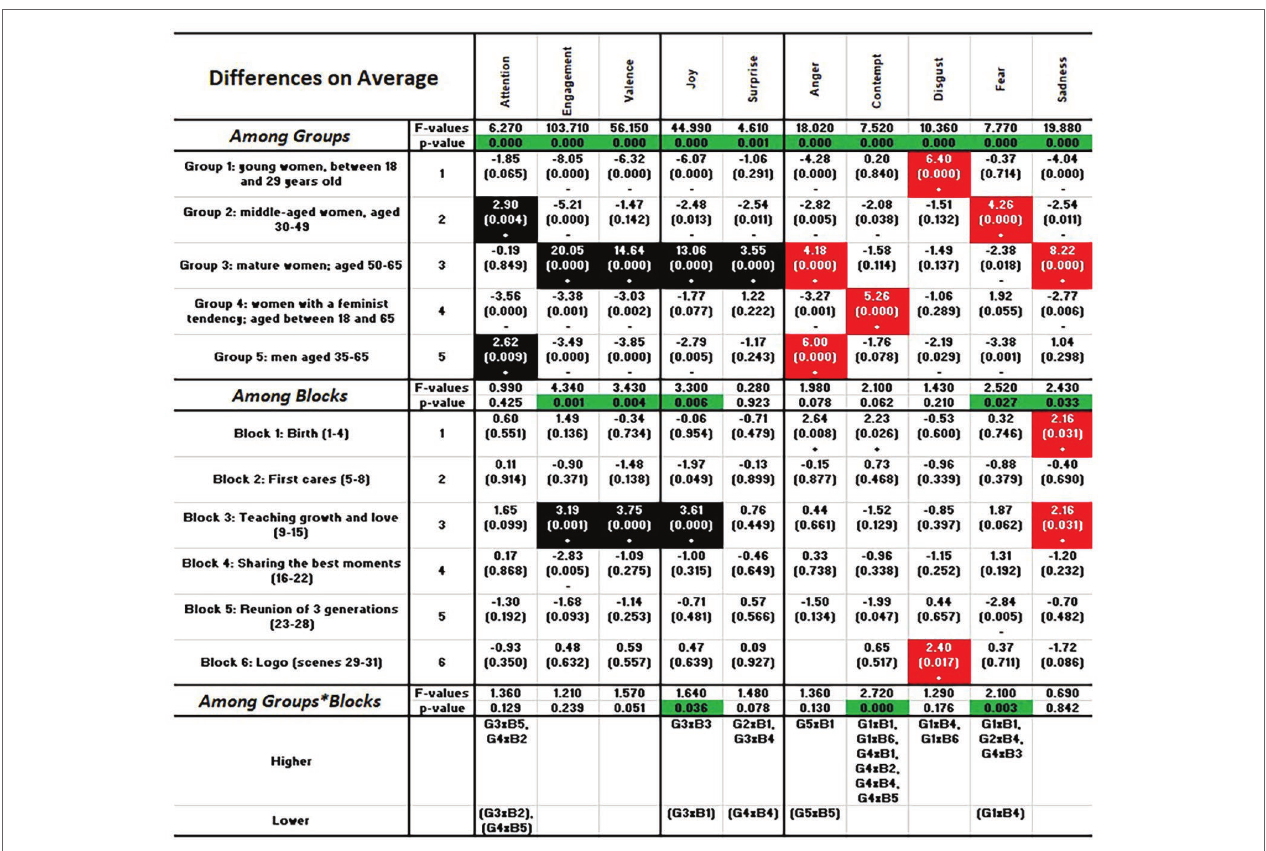
FIGURE 6 | Inferential analysis per group and